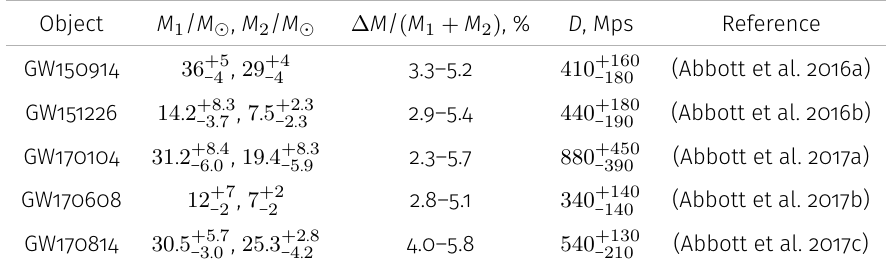
Table I. Parameters of merging binary black holes according to data gravitational-wave observations. The columns indicate (from left to right): the name of the object, the mass of components, the relative change in mass, the distance to object, and